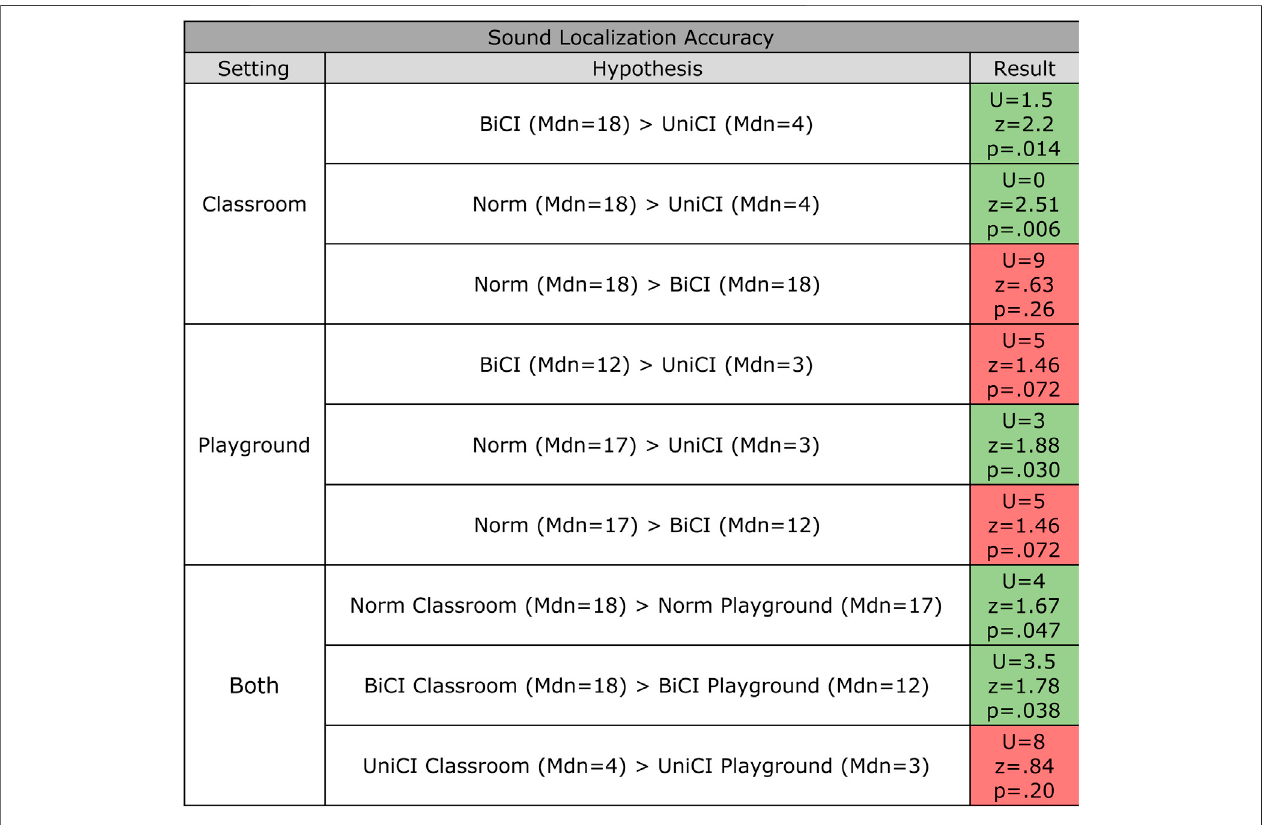
FIGURE 12 | Mann-Whitney U test results for each alternative hypothesis for the sound localization accuracy. The critical value of U at p¡.05 is 4. UniCI, BiCI, and Norm denote simulated unilateral CI, bilateral CI, normal hearing, respectively. Green and red colors indicate the hypothesis is accepted and rejected, respectively.